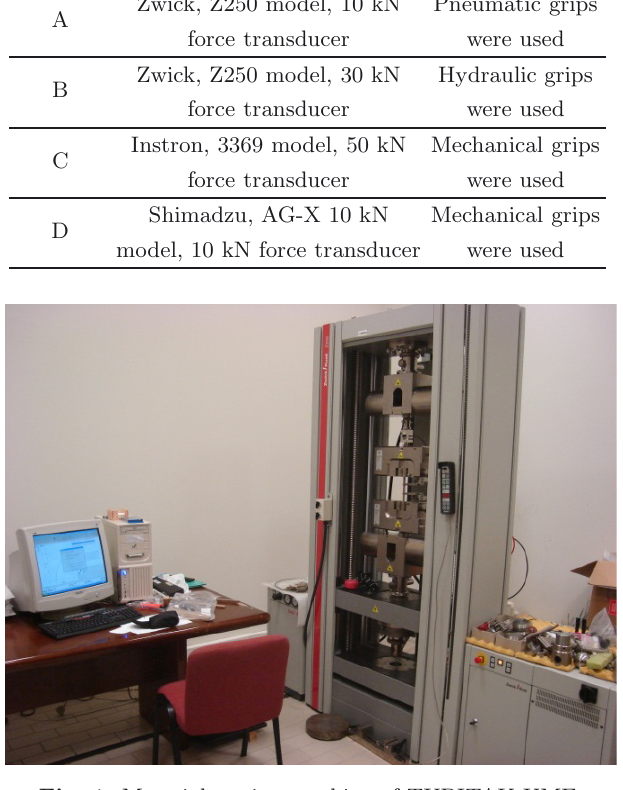
Fig. 1. Material testing machine of TUBITAK UME.